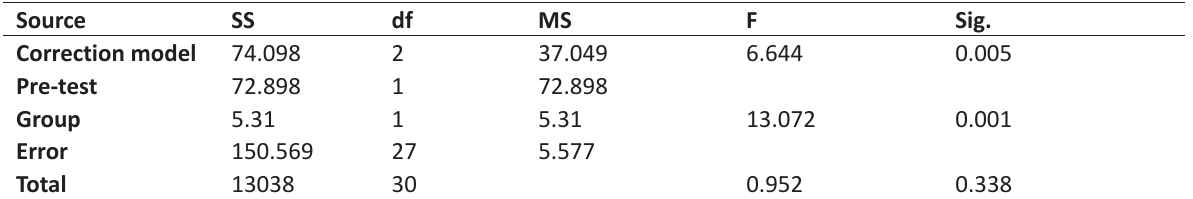
Table 2. Results of the covariance analysis test to examine the effect of two educational methods on the skill of basketball shots